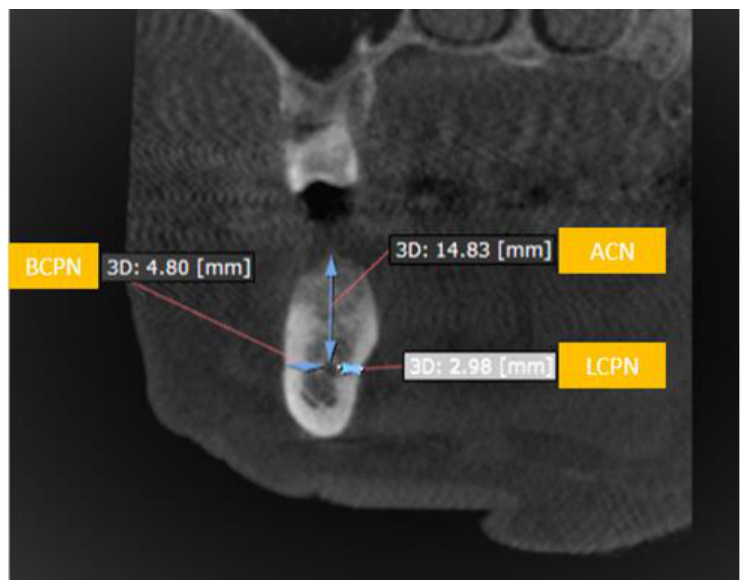
Figure 5. Images of IAN tracing shown using On-Demand 3D computer software with axial plane, panoramic view, transverse cuts and 3D view for dentate subject.